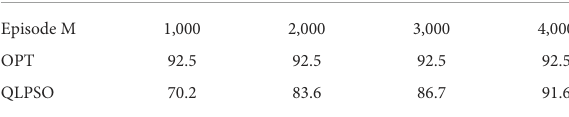
TABLE 7 The effect of training number on average reward value